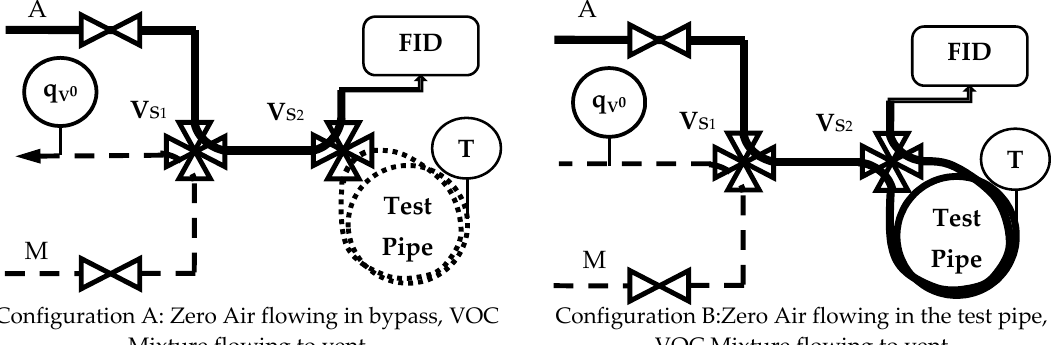
Figure 2. Device connections for monitoring the VOC Mixture and Zero Air in bypass and test pipe. The solid line represents the Zero Air and the dashed line shows the VOC Mixture the dotted line is without flow.